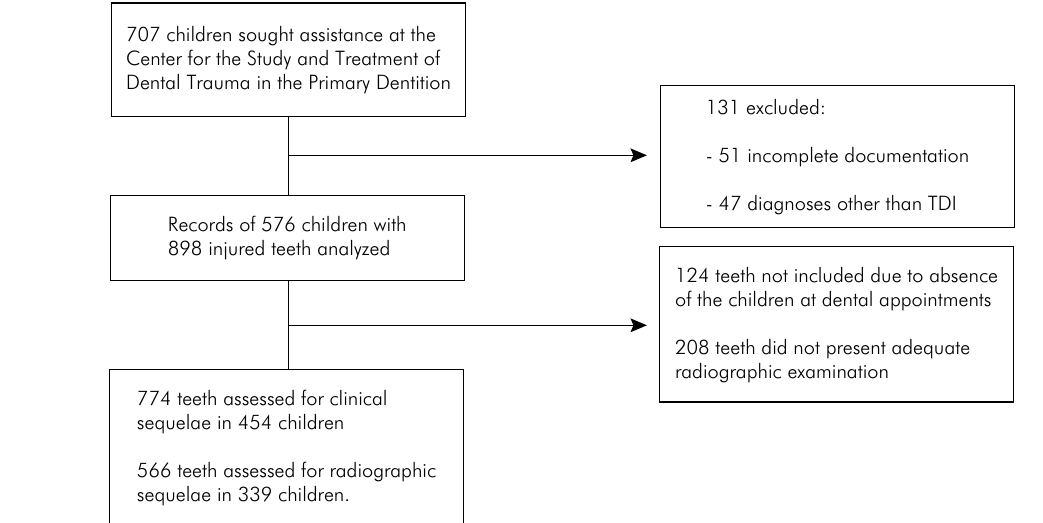
Figure 1. Flowchart of the study conducted in the Center for the Study and Treatment of Dental Trauma in the Primary Dentition